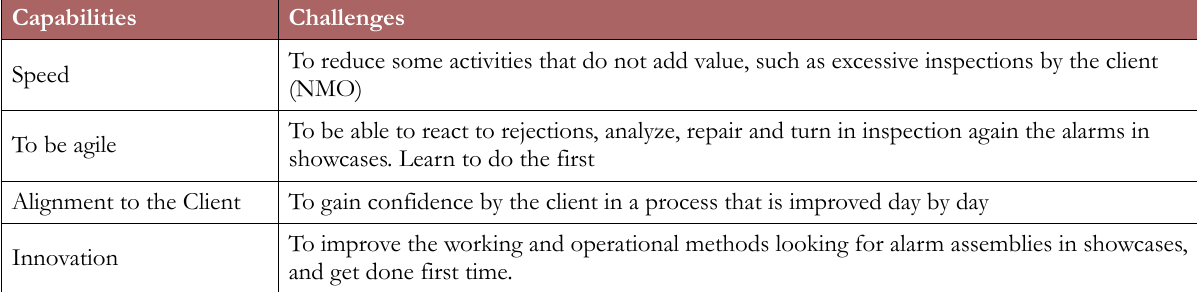
Table 2. Capabilities and